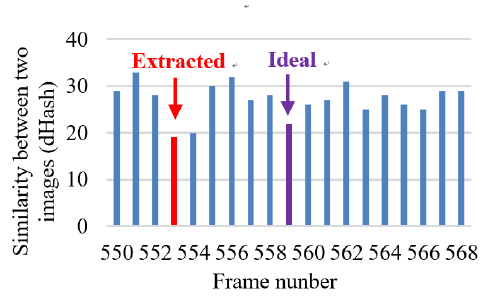
Figure 4. dHash value near the maximum error